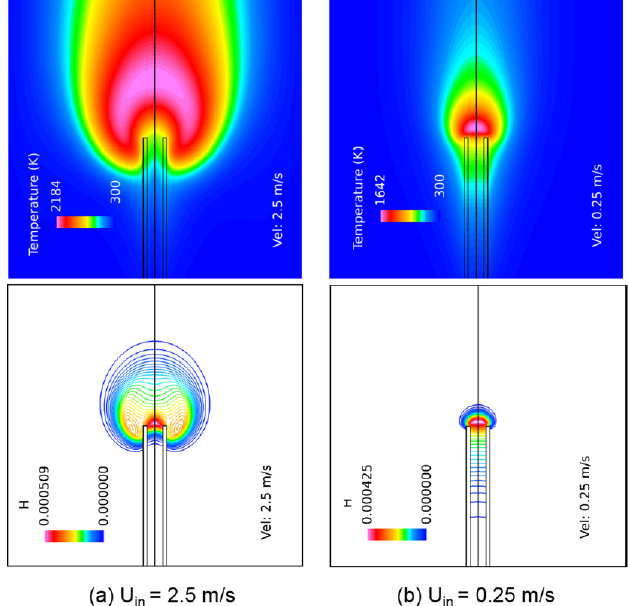
Figure 11. Numerical study of hydrogen-air jet flames in a micro burner by Hossain and Nakamura [22]. 2D temperature and mass fraction of H-atom distributions for different fuel ejecting velocities (( a ) U in = 2.5 m/s and ( b ) U in = 0.25 m/s) over titanium